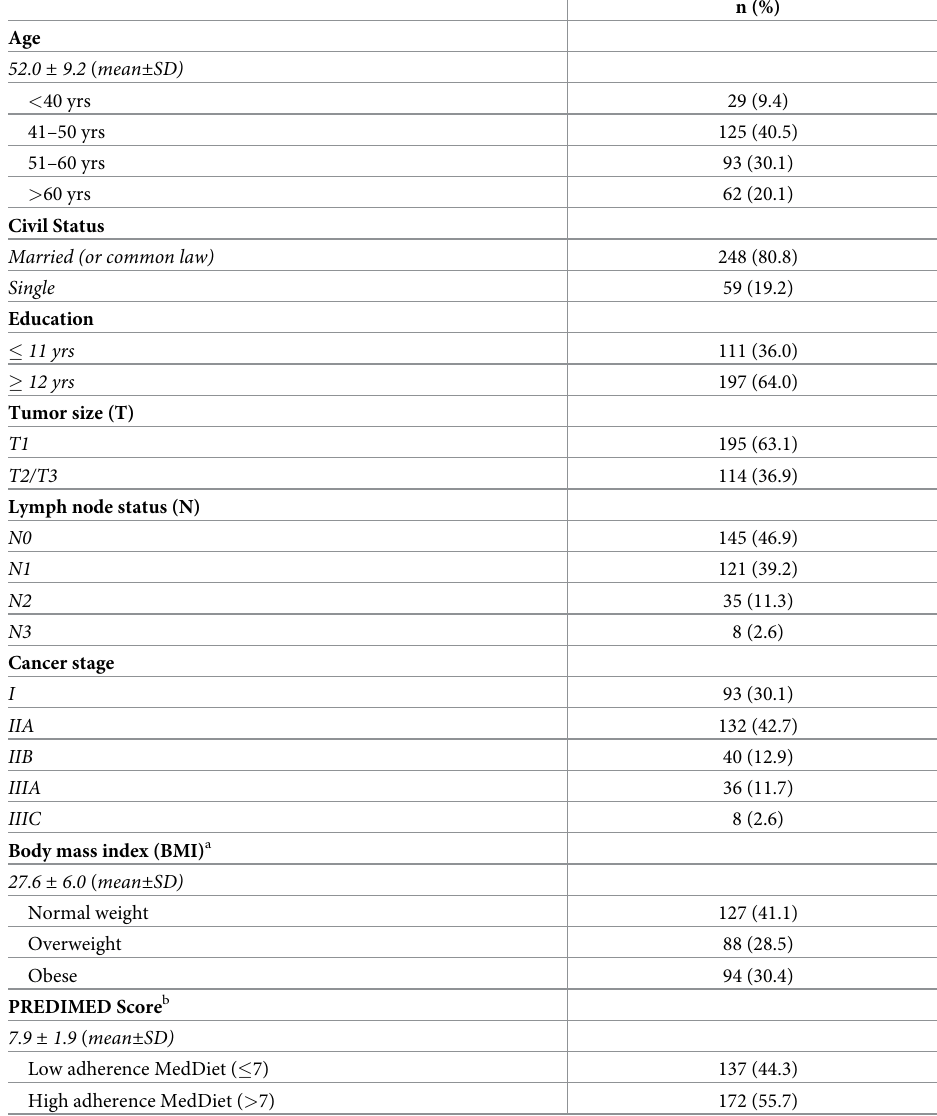
Table 1. Demographic characteristics of the participants (n =